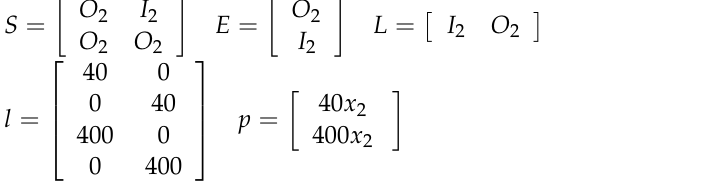
x estimation; ( d ) State